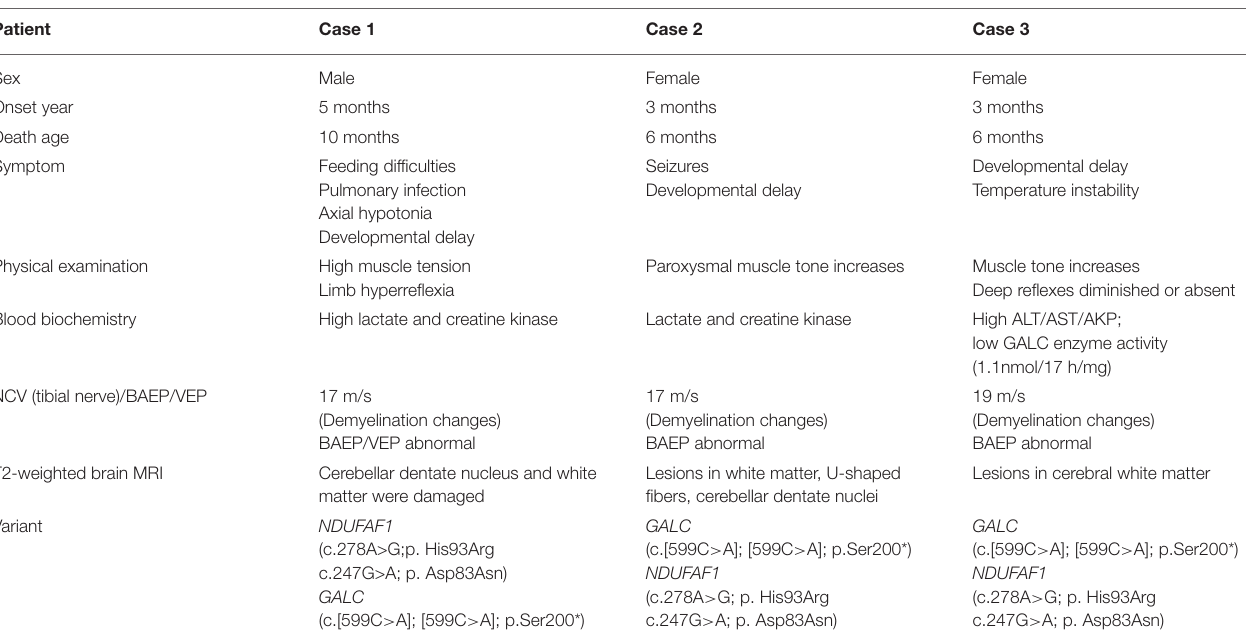
TABLE 1 | Clinical characteristics of three cases in the